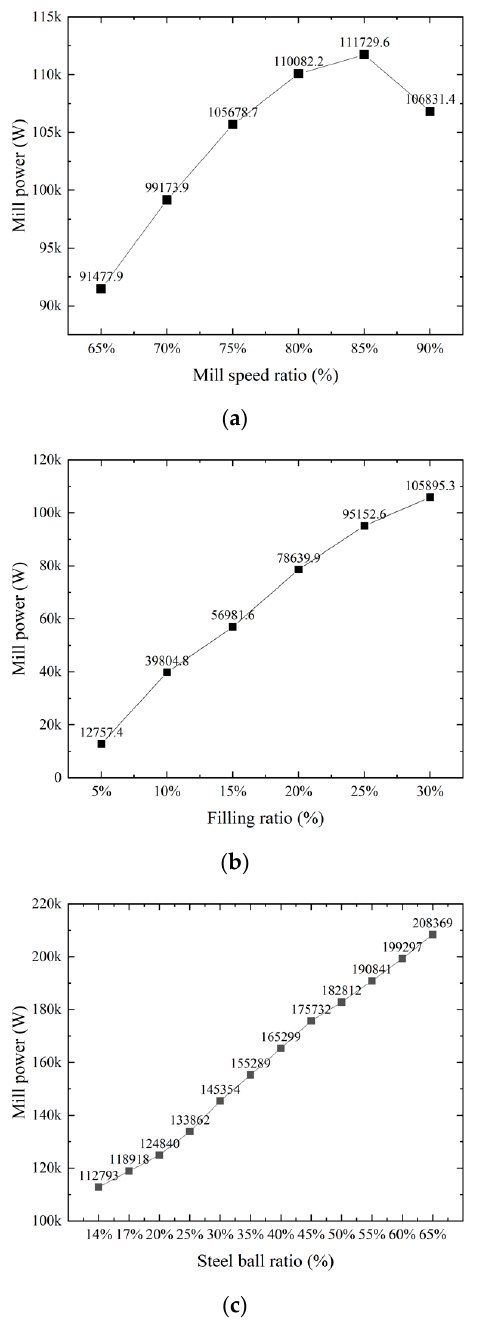
Figure 7. Mill power curve of single parameter. ( a ) Mill power of different speeds; ( b ) Mill power of different fill level ratio; ( c ) Mill power of different steel ball ratio.